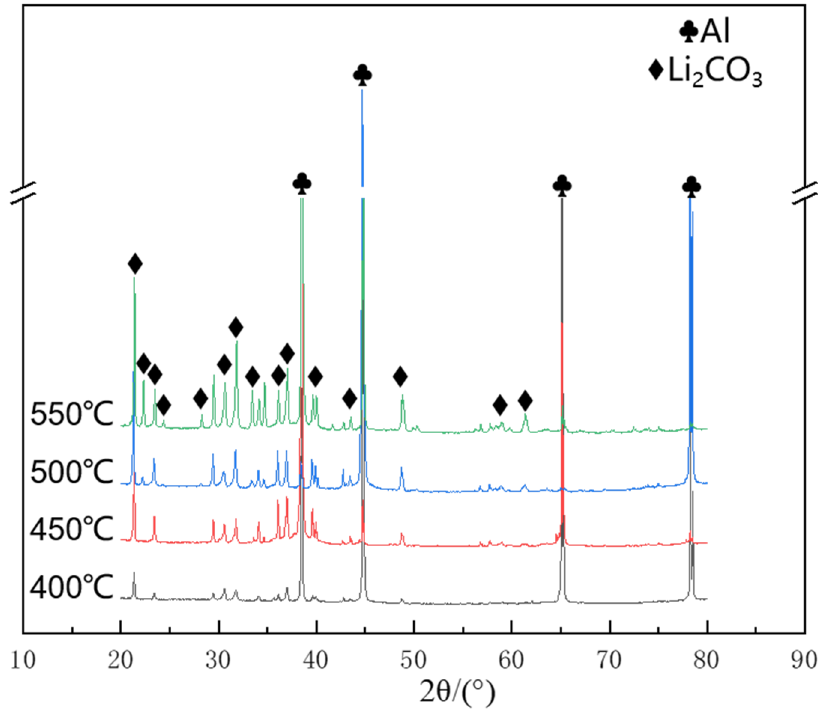
Figure 9. XRD pattern of Al-2Li alloy oxidized at different temperature for 5 h. The XRD phase analysis results of the Al-2Li-0.2Sc alloy with a Sc element show that the Li 2 CO 3 peak formed by oxidation at 400 °C and 450 °C is relatively weak, while the Li 2 CO 3 peak formed by oxidation at 500 °C and 550 °C is gradually enhanced—that is, the Li 2 CO 3 produced increases. However, no Sc-containing phase was detected in the oxide film of the Al-2Li-0.2Sc alloy with a Sc element added, because Li’s activity was higher than that of oxygen, and the resulting oxide film covered the surface of the alloy.